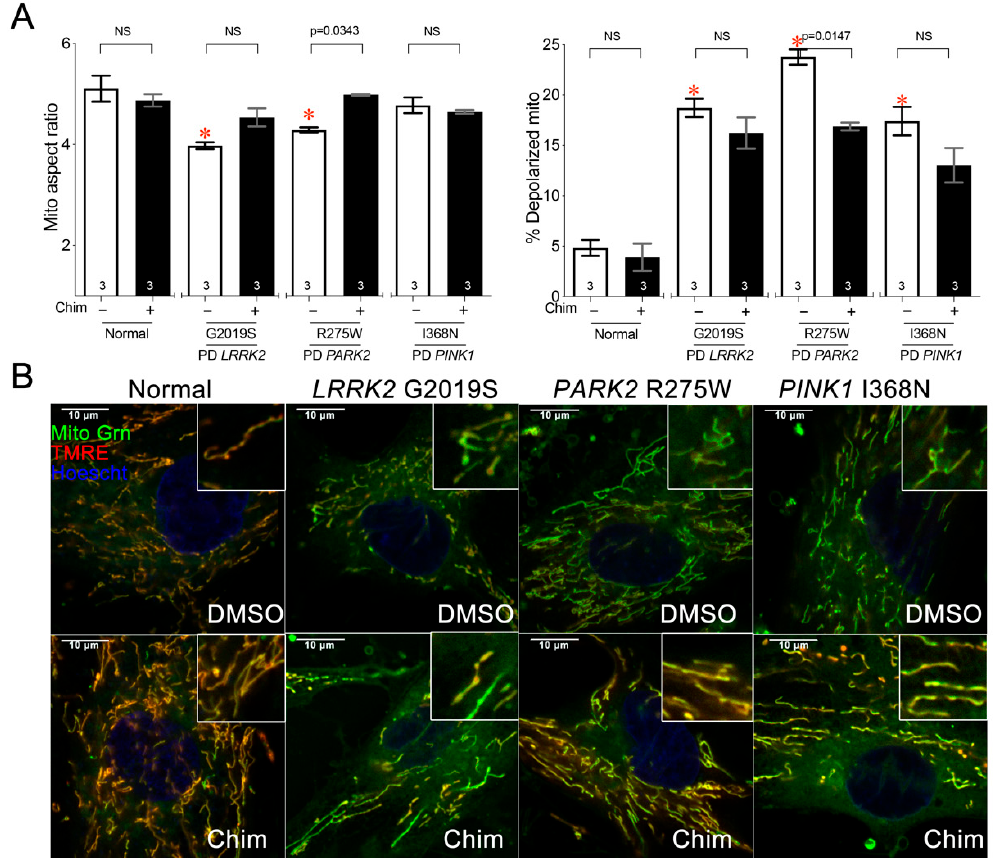
Figure 4. PARK R275W Parkinson’s disease fibroblasts exhibit mitochondrial depolarization that is improved by mitofusin activation. ( A ) Quantitative results for mitochondrial aspect ratio (left) and depolarization (right) of galactose-cultured normal and PD patients’ fibroblasts treated with 100 nM Chimera or DMSO vehicle. Data are means ± SEM; p values by two-way ANOVA; * = p < 0.05 vs. vehicle-treated normal fibroblasts; individual p values are given for Chimera vs. vehicle within each genotype. NS = Nonsignificant. The number of independent experiments is shown on the bottom of each bar. ( B ) Representative confocal images of studies in panel ( A ); staining and imaging as in Figure 1.